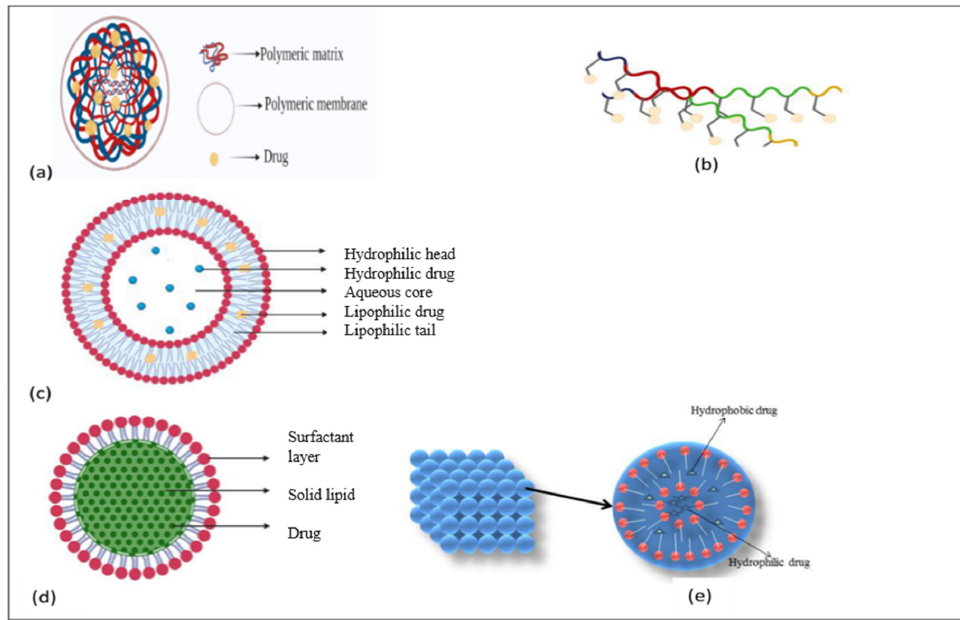
Figure 3. Nanoparticles for AD treatment: ( a ) Polymeric nanoparticle; ( b ) Aptamer; ( c ) Liposomes; ( d ) Solid lipid nanoparticle; and ( e ) Cubosomes.